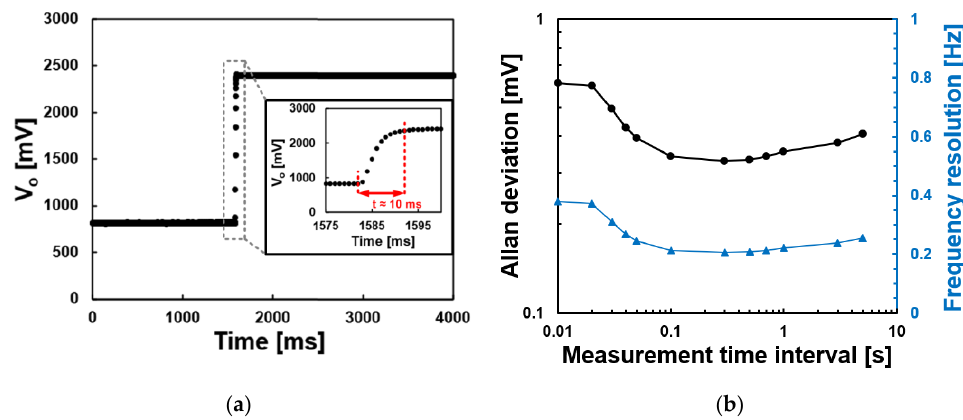
Figure 6. Frequency resolution of the developed miniaturized QCM system: ( a ) step response to determine the minimum measurement time, and ( b ) Allan deviation plot.